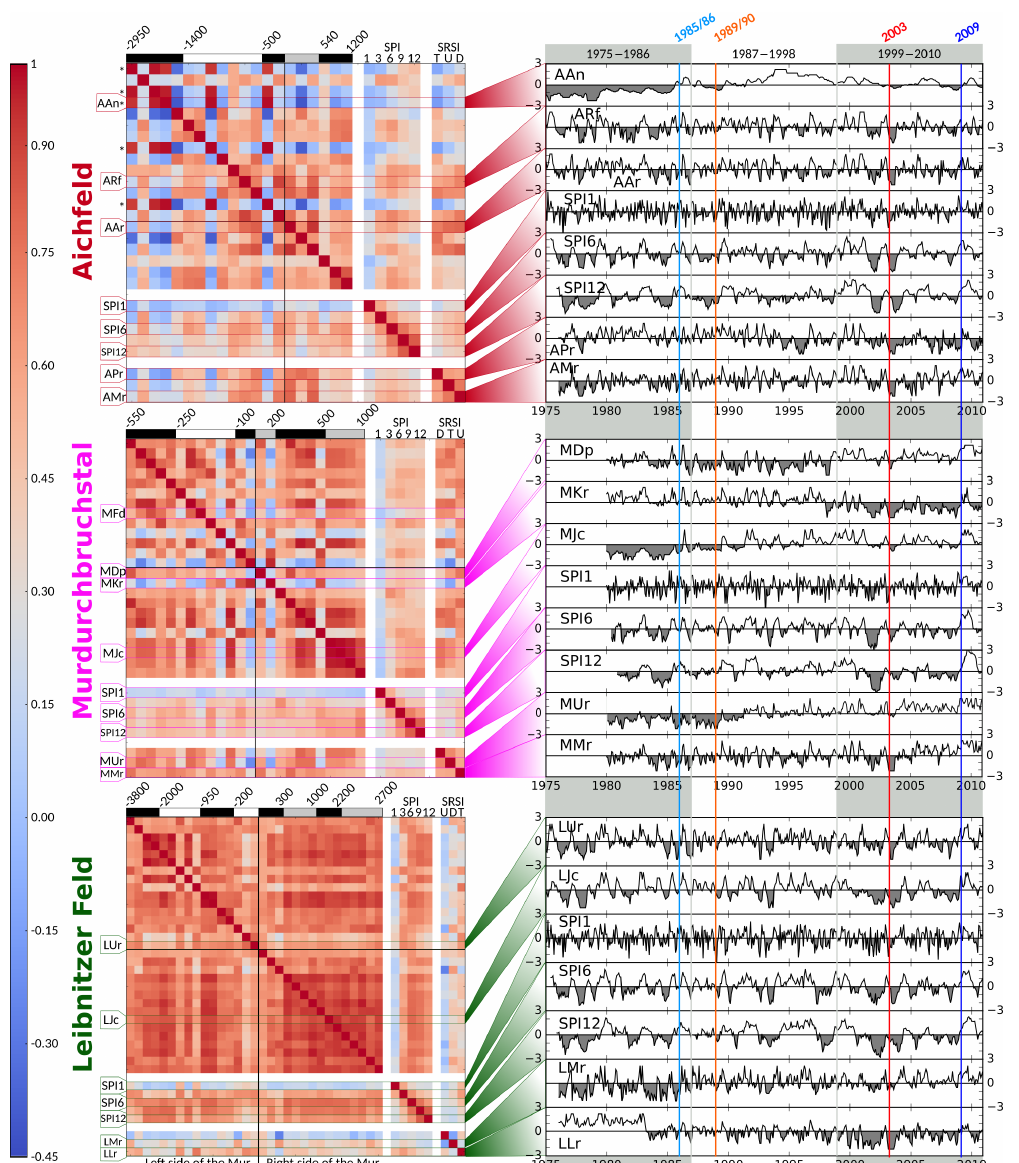
Figure 2. Correlation matrices for the three subregions (left side) with selected time series for SGI, SPI and SRSI (right side). The data for each subregion is sorted in three groups, divided by blank columns and rows: 1 – Groundwater, SGI, sorted by distance of the well to the stream, given in meters on the top of the matrices; 2 – Precipitation, SPI1, 3, 6, 9 and 12; 3 – Surface water, SRSI, for different Mur gauges or streams in the subregion (U: Mur upstream, D: Mur downstream, T: Tributary stream). Deep wells in the Aichfeld are marked with an asterisk ∗ . The three letter markers on the left highlight selected wells and river stages discussed in the text; see also Table 1. Also shown are the time periods used in Sect. 3.4 and Fig. 5, the years 1985/86 and 1989/90 used in Sect. 3.3 and Fig. 4, and the years 2003 and 2009 used in Sect. 3.2 and Fig. 3. For further details on correlation matrices, please refer to Appendix